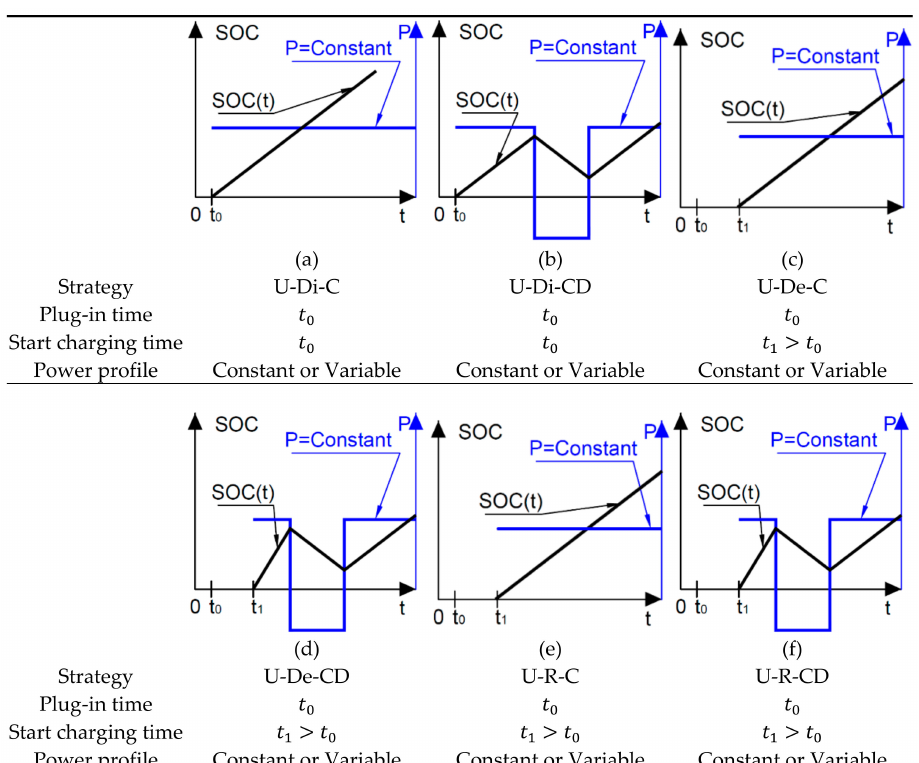
Figure 2. Illustration SOC and Discharge Power for Uncoordinated